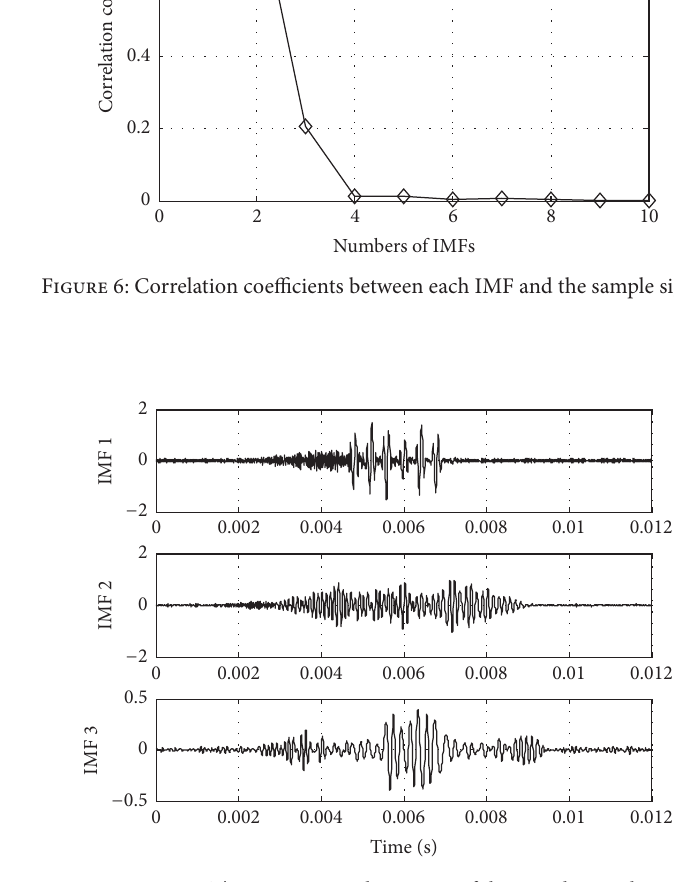
Figure 7: The IMFs 1–3 in the EEMD of the sample